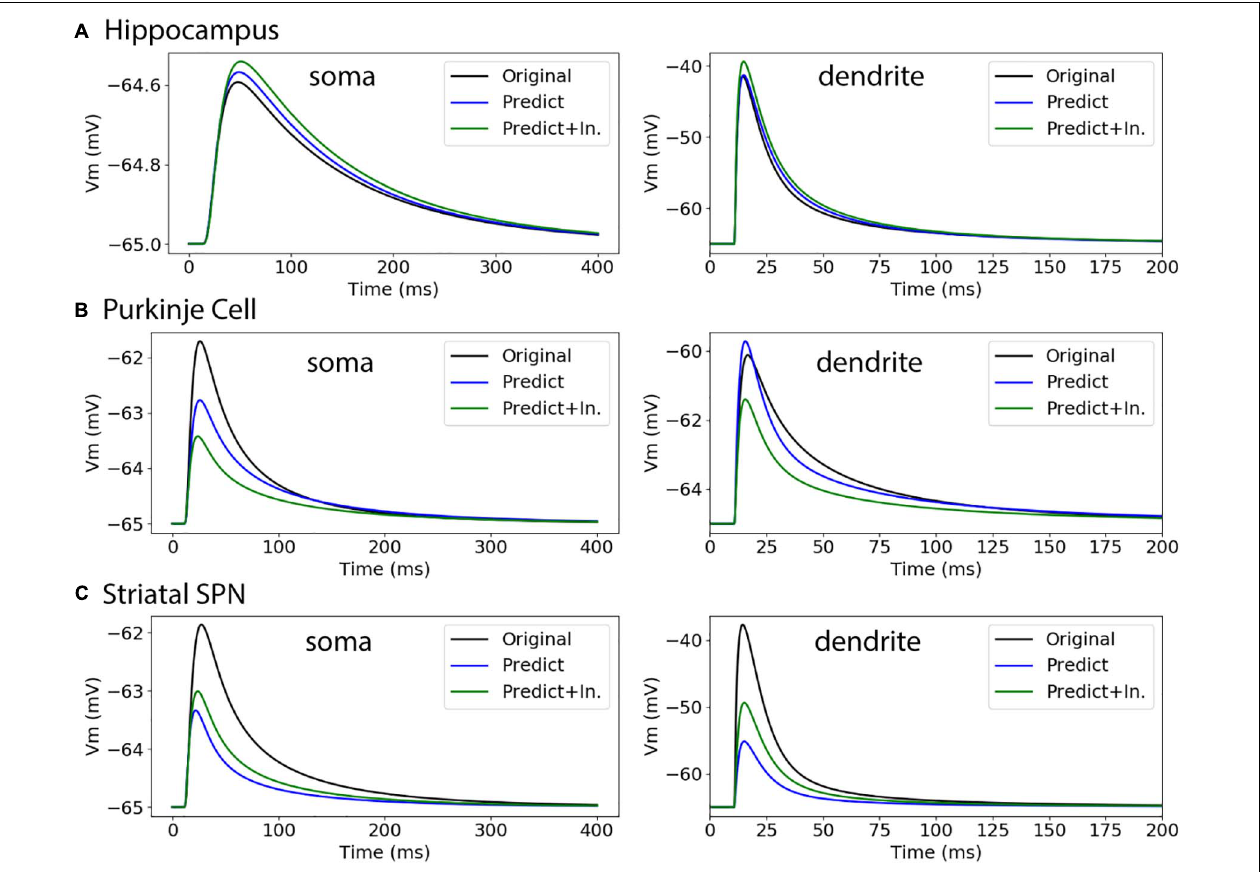
FIGURE 10 | Passive response to synaptic input. (A) Hippocampal CA1 pyramidal cell (NMO_35137), with apical and basal dendrites, compartment 32_3. (cid:49) V ratio = 0.009 for dendritic response. (B) Cerebellar Purkinje cell (NMO_10073), compartment 12_3. (cid:49) V ratio = 0.082 for dendritic response (C) Striatal SPN (NMO_33253), compartment 19_3. (cid:49) V ratio = 0.639 for dendritic response, and improved to 0.427 using original initial